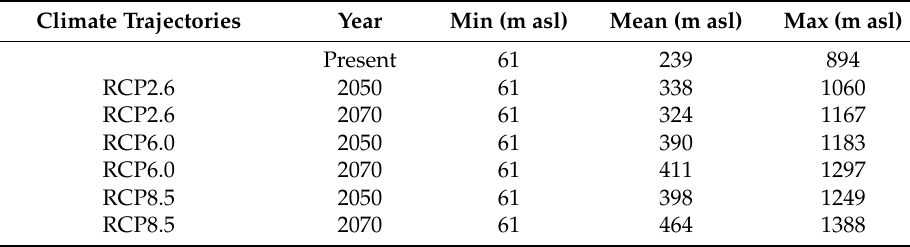
Table 2. Distribution of climate suitable areas along the elevation